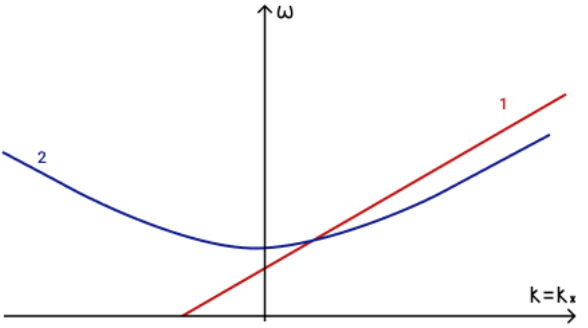
Figure 17. Phase matching condition for two magnetogravity waves and one Alfvén wave: 1—